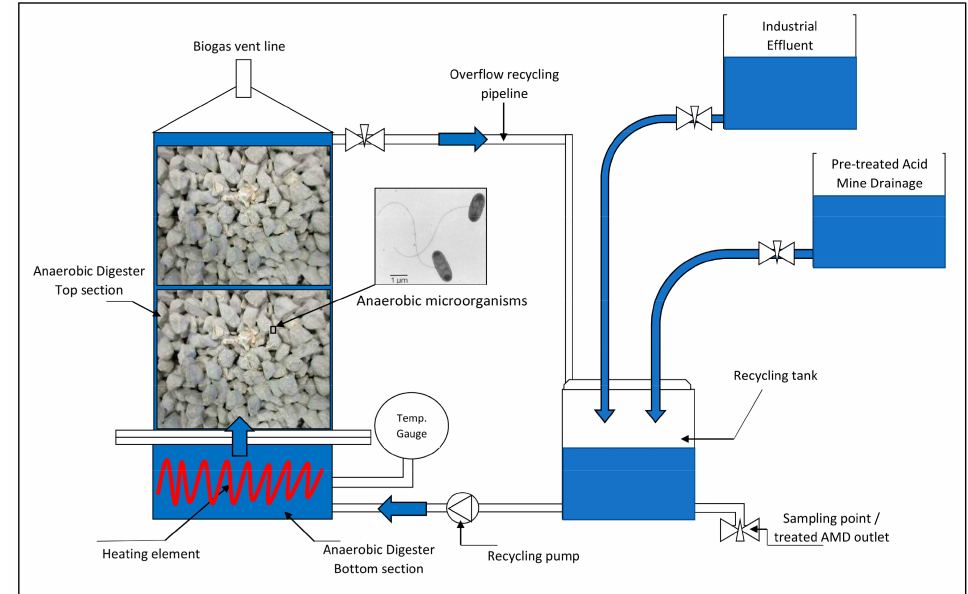
Figure 2. Schematic layout of the bioreactor.